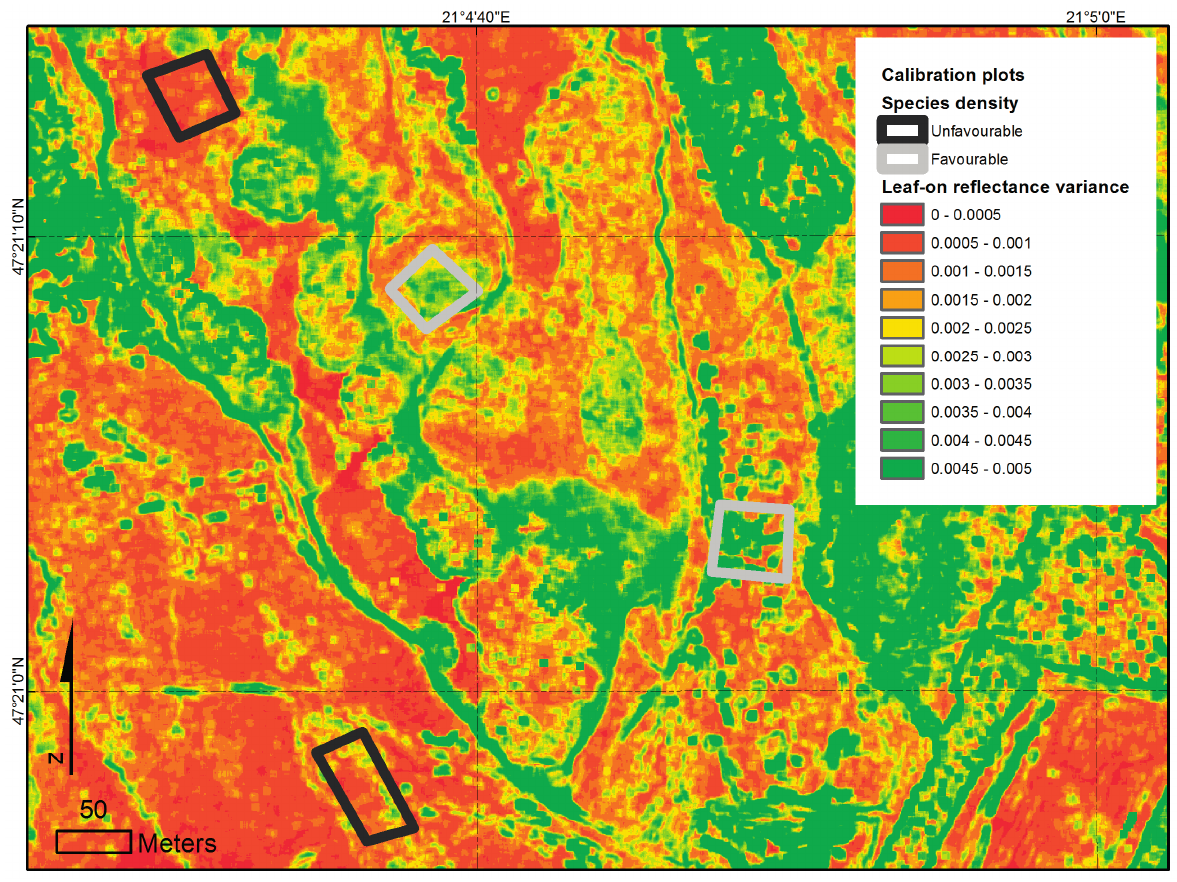
Figure 3. Example of calibrating the scoring layer “species density”. Based on this example, the threshold for favorable species density would be ca.